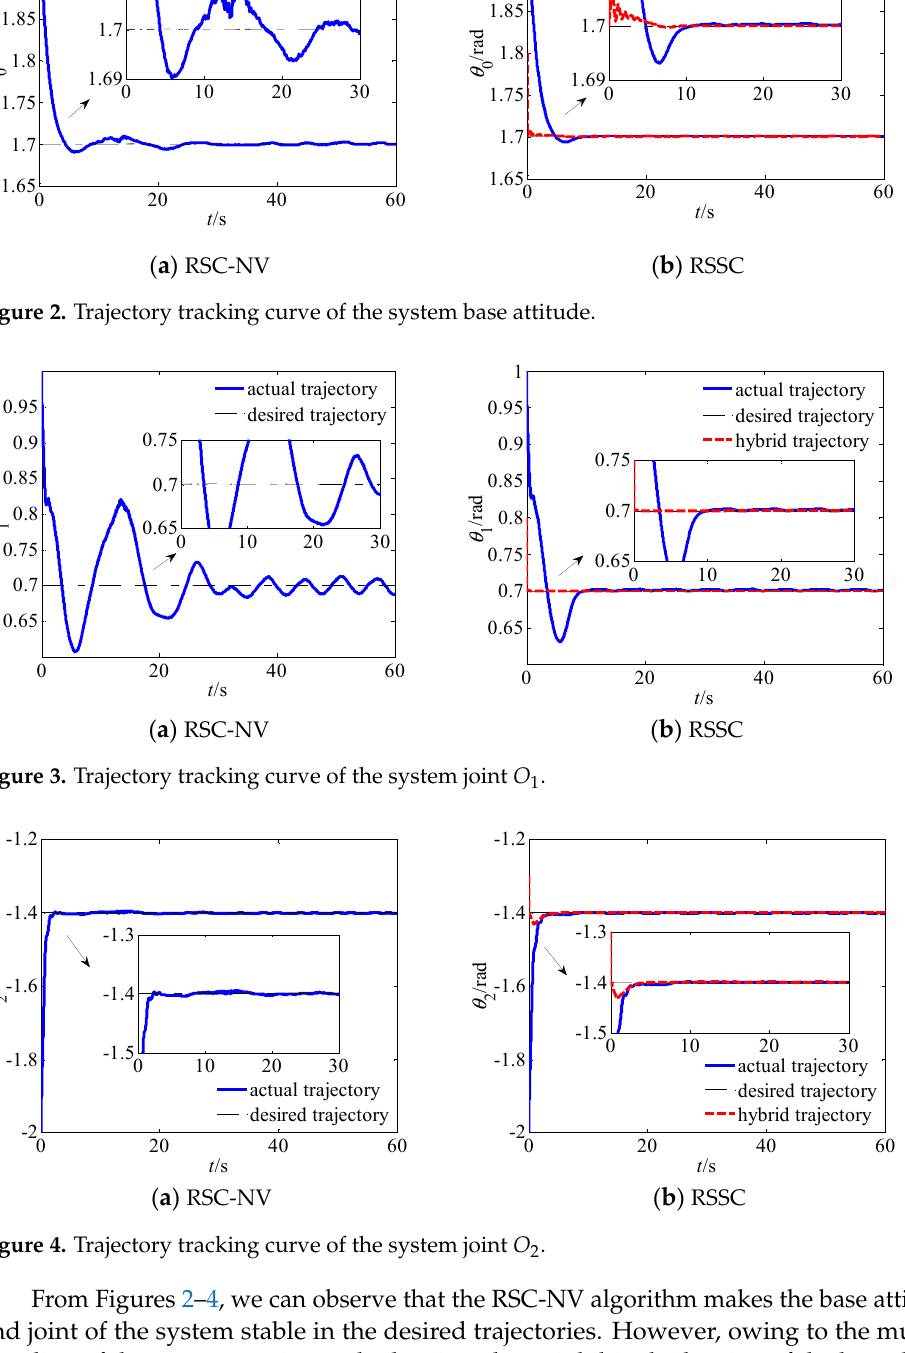
O . Figure 4. Trajectory tracking curve of the system joint O 2 2 O . 2 O . 2